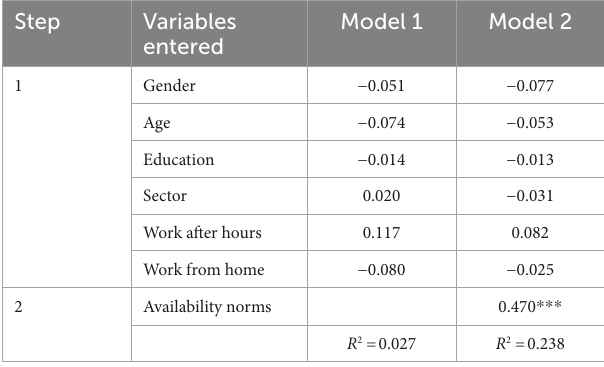
TABLE 4 Multiple linear regression of Telepressure on predictor